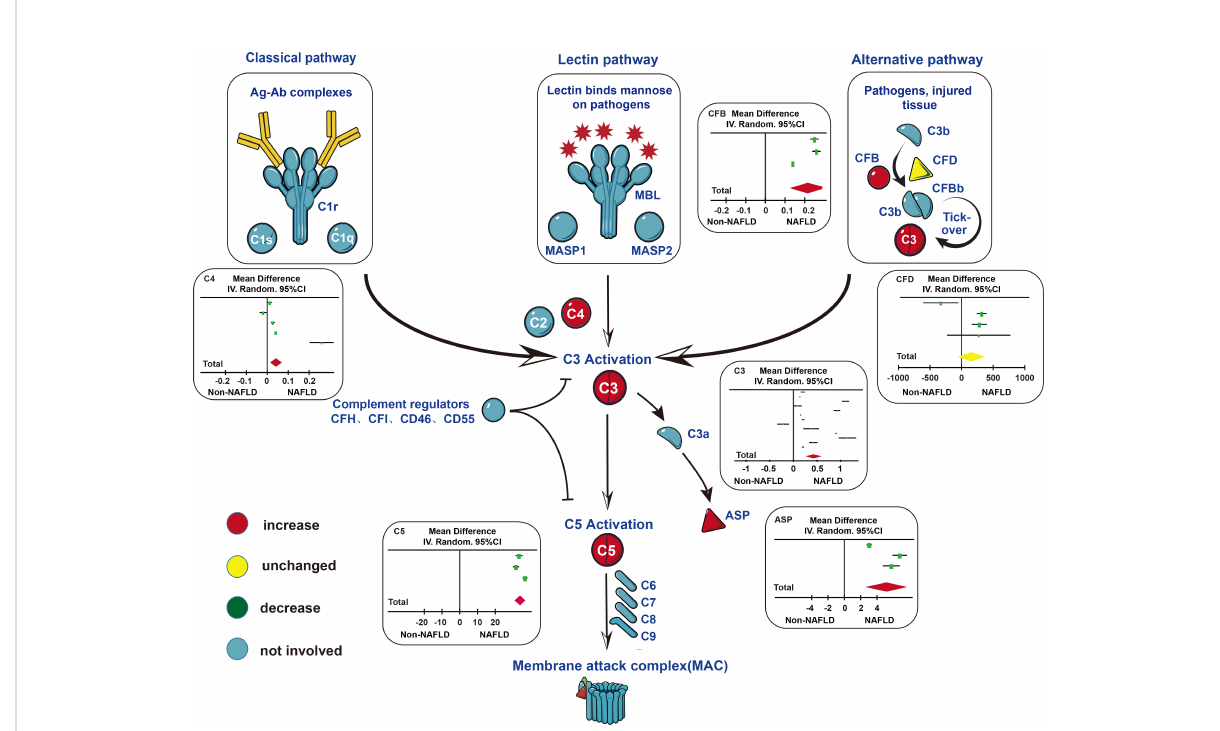
FIGURE 5 Changes of complement components in three main pathways of complement system activation. In the classical pathway and lectin pathway, serum C4 levels in patients with NAFLD were higher than those in the control group. In the alternative pathway, serum CFB levels in patients with NAFLD were higher than those in the control group. In the subsequent common pathway, serum C3, C5, ASP levels in patients with NAFLD were higher than those in the control group. Abbreviations: ASP, acylation stimulating protein; C1r, complement component 1 r; C1s, complement component 1 s; C1q, complement component 1 q; C2, complement component 2; C3, complement component 3; C4, complement component 4; C5, complement component 5; C6, complement component 6; C7, complement component 7; C8, complement component 8; C9, complement component 9; CFB, complement component B; CFD, complement component D; CFH, complement component H; CFI, complement component I; CD46, Membrane cofactor protein (MCP); CD55, Decay-accelerating factor (DAF); MAC, membrane attack complex; MASP, mannose-binding lectin-associated serine protease; MBL, mannose-binding